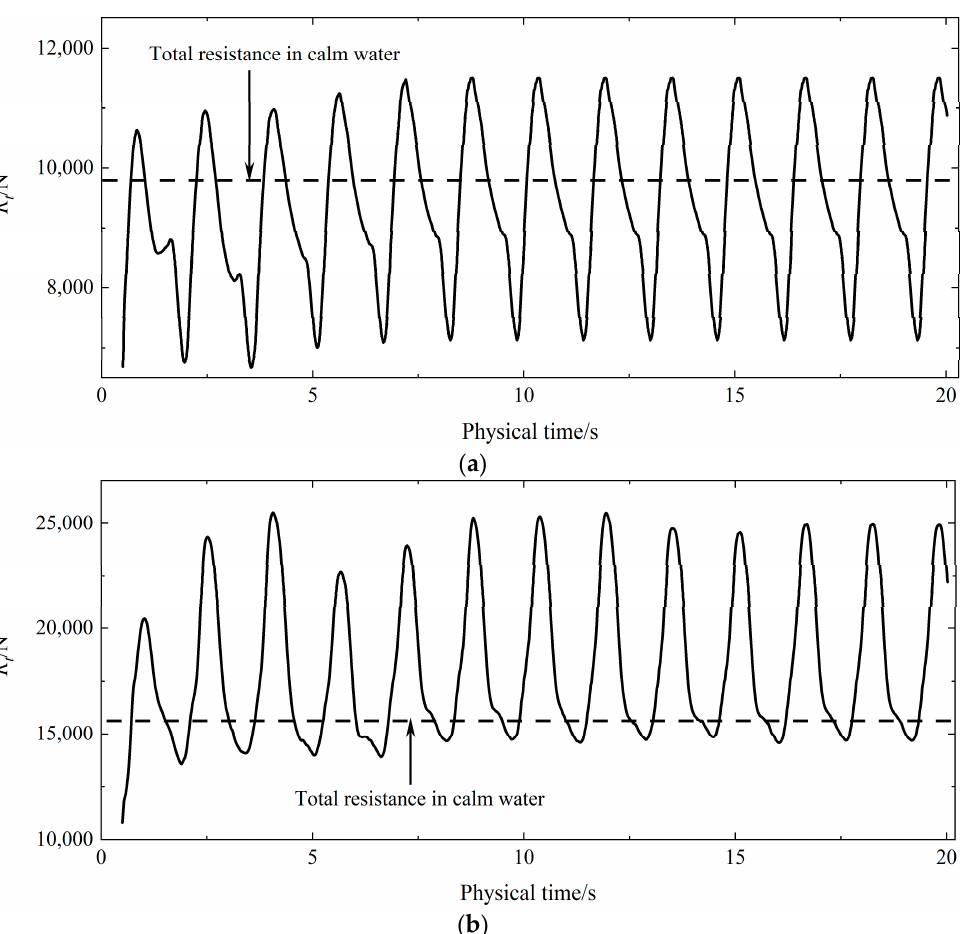
Figure 21. The time history curve of total resistance under case 7: ( a ) monohull; ( b ) pentamaran.